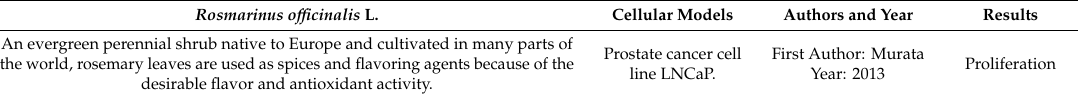
Table 6. Schematic representation of in vitro cellular models used to test the role of Rosmarinus o ffi cinalis